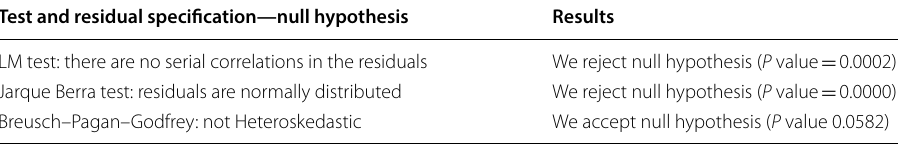
Table 6 Residual diagnostic result of the first model. Source : Calculated by the author Test and residual specification—null hypothesis